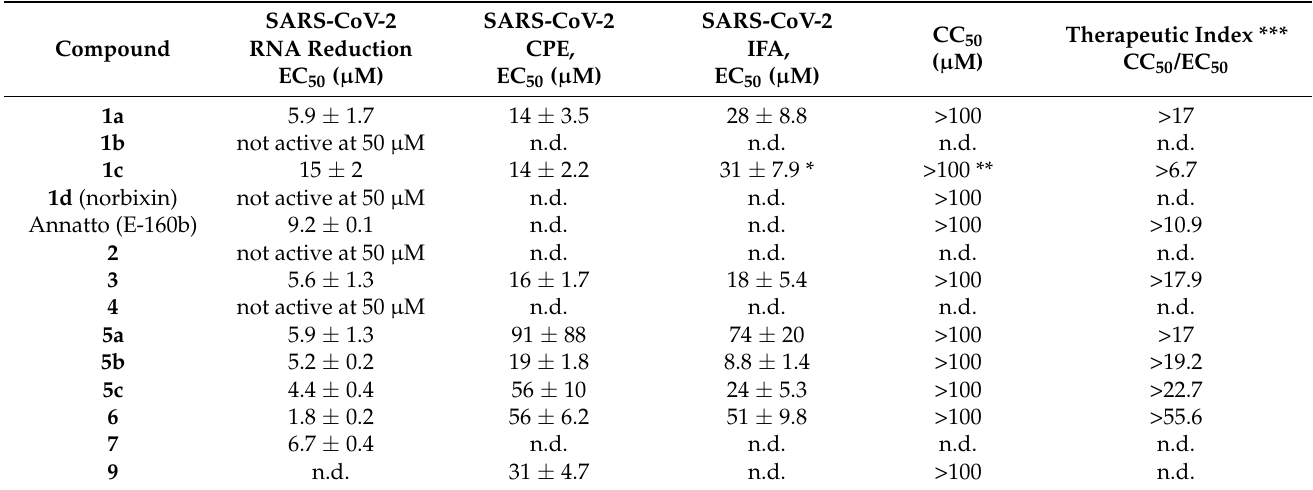
Table 1. Antiviral effects of the glycopeptide conjugates and carotenoids according to the three assays.